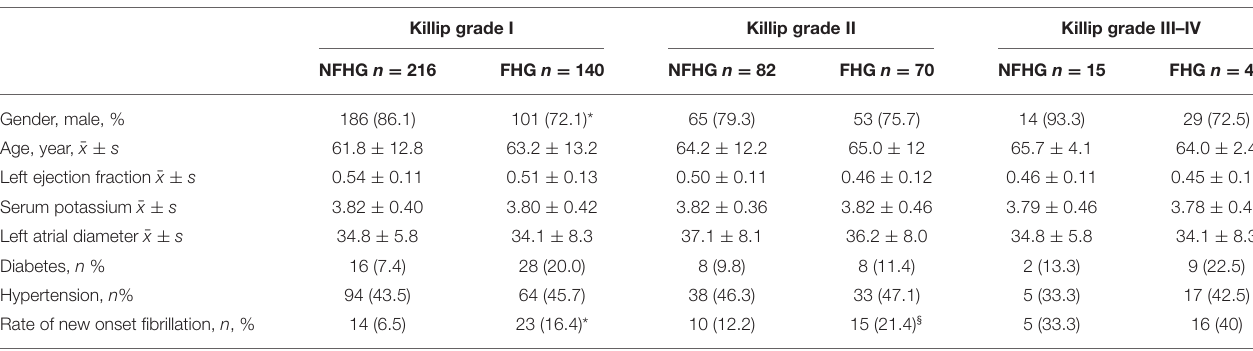
TABLE 2 | Sub-group